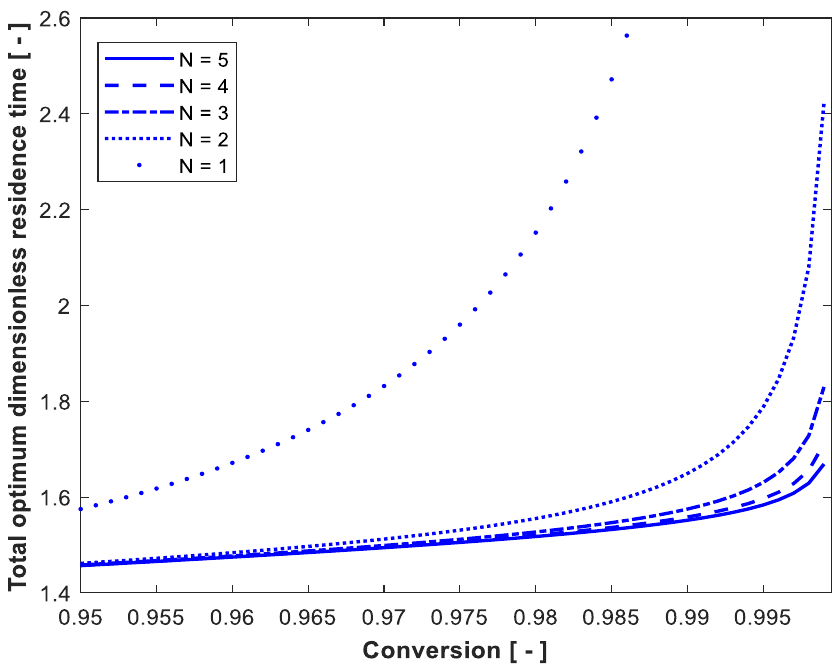
Figure 3. Effect of substrate conversion on the total optimum dimensionless residence time. S o = 30 g/L, X o = 0, P o = 0.